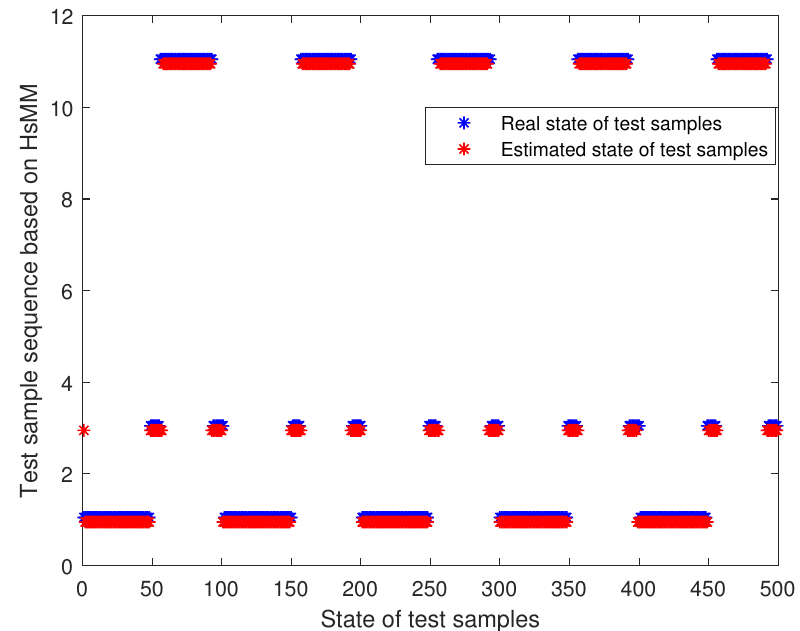
Figure 5. Comparison diagram of real state and estimated state of test samples based on HSMM when parameter D =